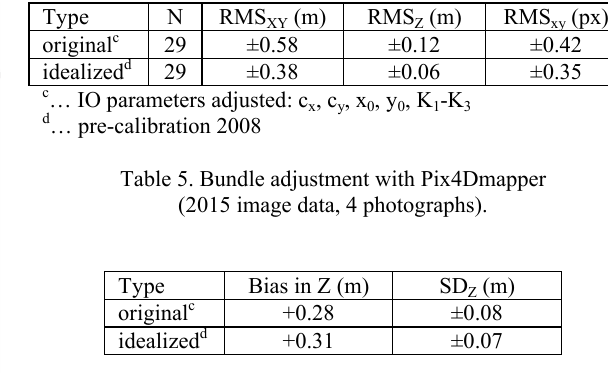
Table 6. Accuracy of longitudinal profile. Photogrammetric data using Pix4Dmapper (4 photographs).